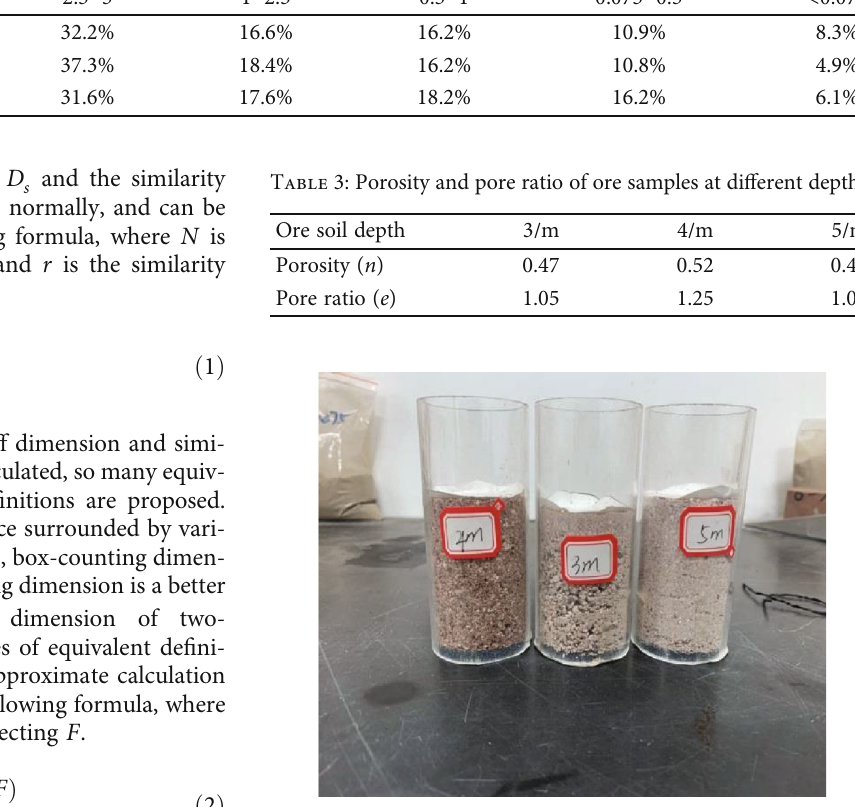
Figure 2: Rare earth samples at di ff erent